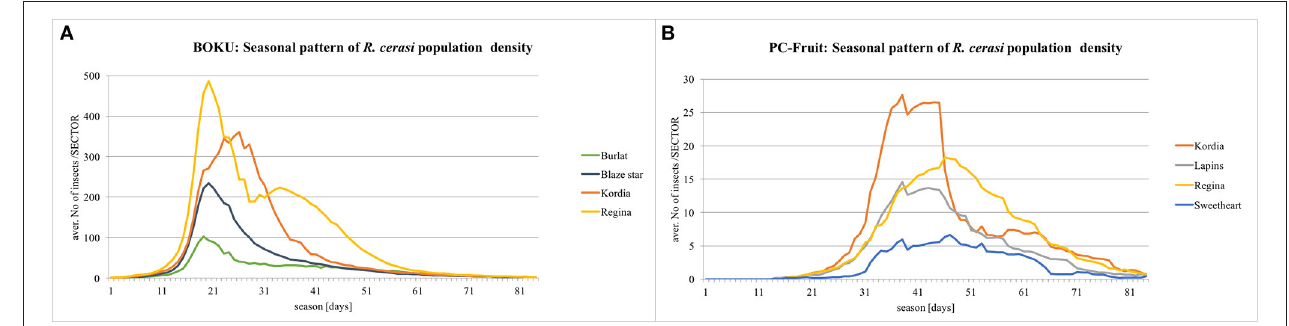
FIGURE 4 | Simulated seasonal patterns of R. cerasi population density. Assumption: NO pesticide treatment on the whole